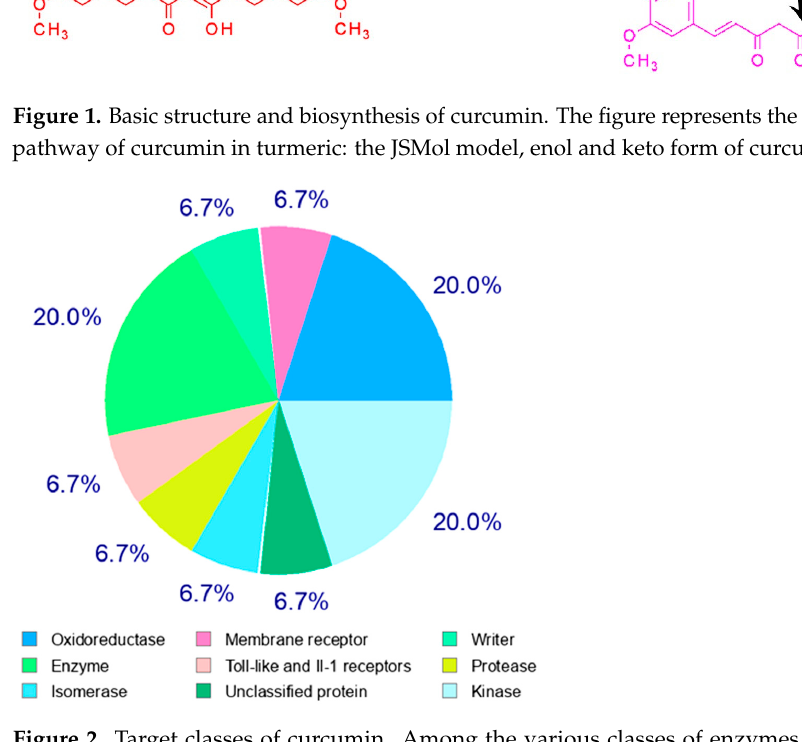
Figure 2. Target classes of curcumin. Among the various classes of enzymes,